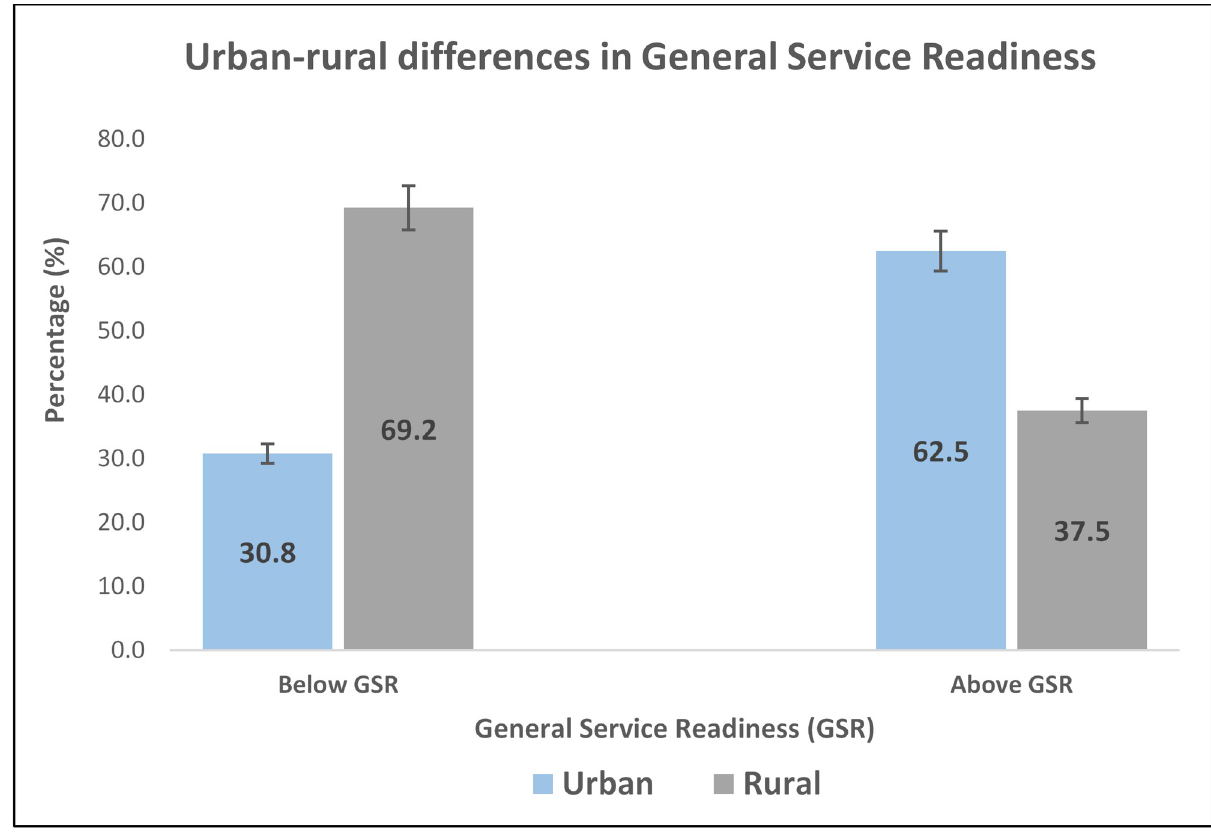
Fig 3. Urban-rural comparison of general service